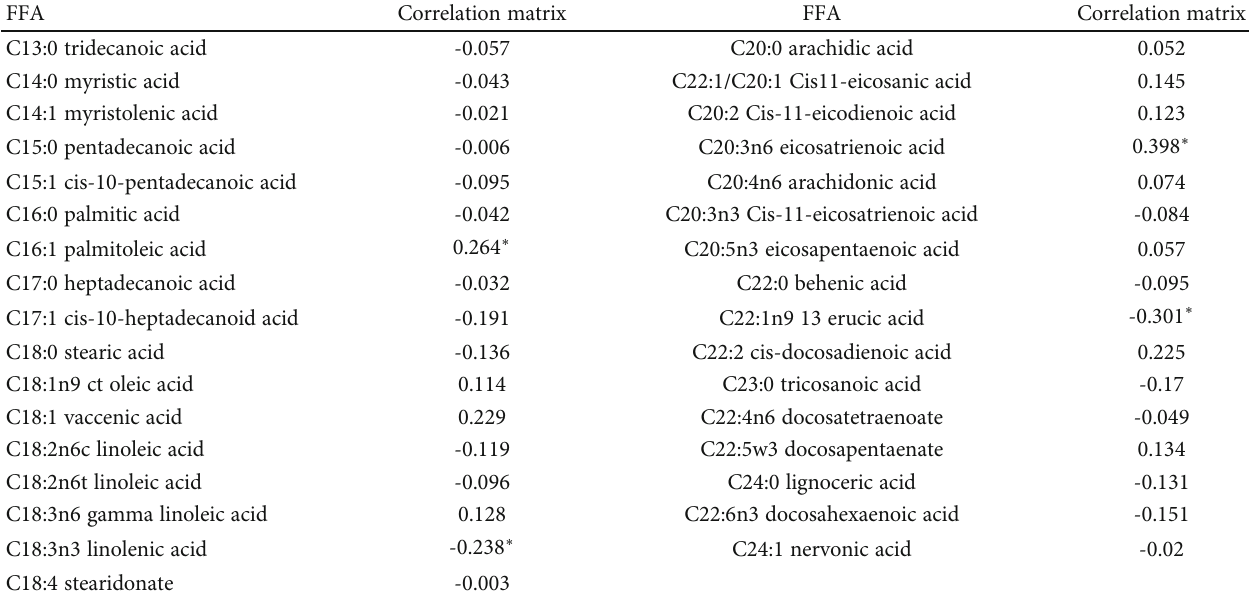
Table 1: Correlations between BDNF and FFA